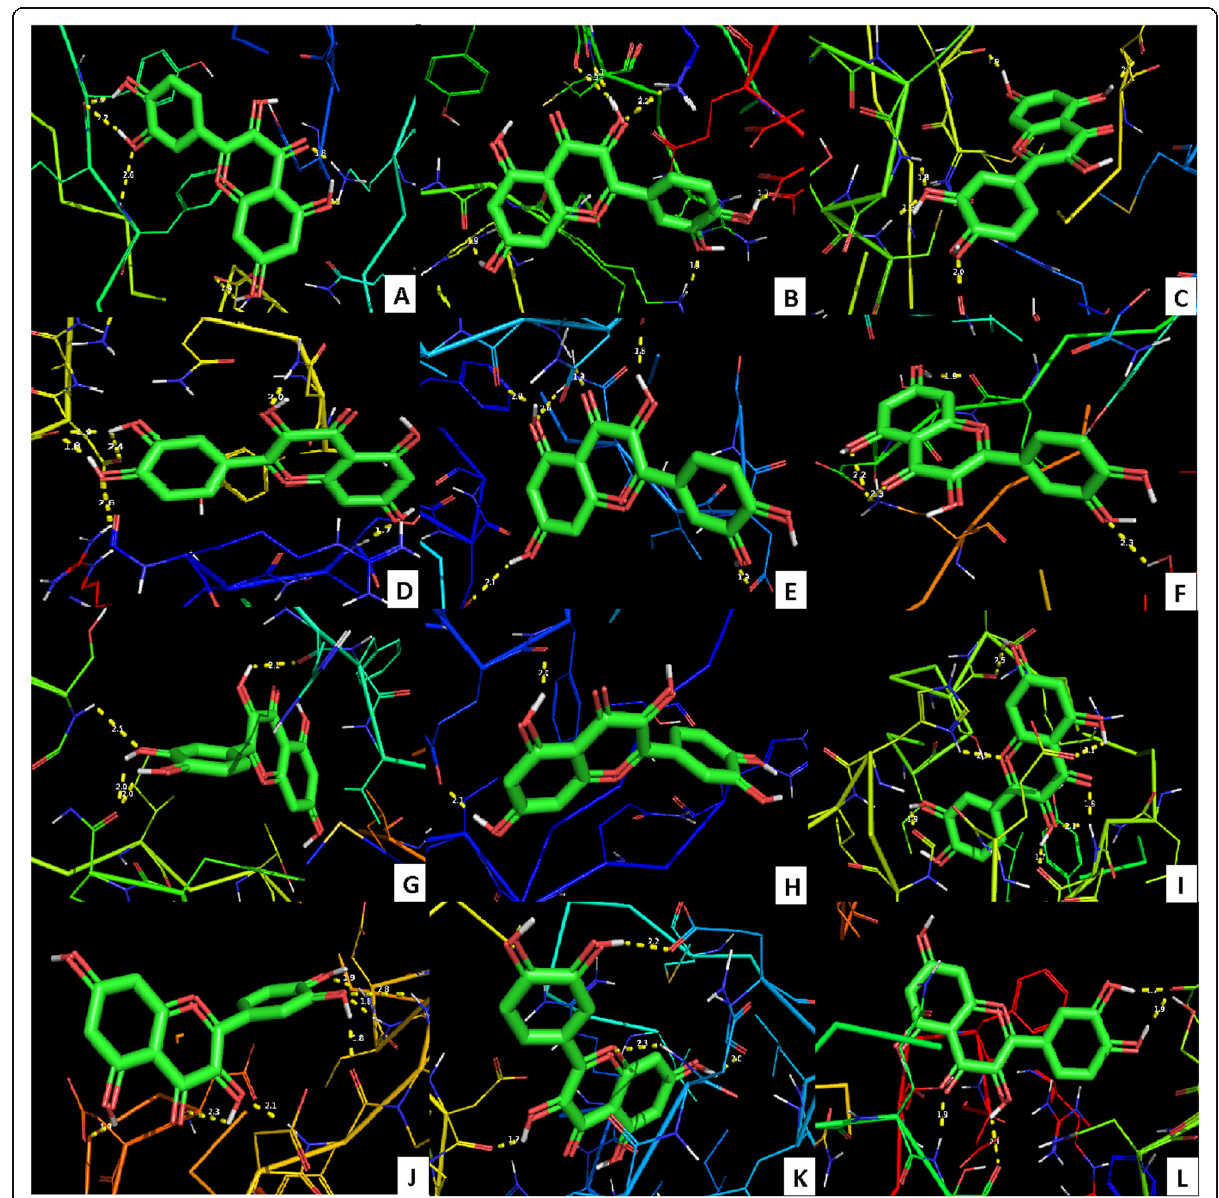
Fig. 2 Molecular docking of key proteins with quercetin. a 2019-nCoV main protease (PDB ID: 6LU7). b 2019-nCoV main protease (PDB ID: 6Y84). c 2019-nCoV main protease (PDB ID: 6YB7). d 2019-nCoV receptor-binding domain of the surface spike glycoprotein (PDB ID: 6M17). e 2019-nCoV spike glycoprotein (PDB ID: 6VXX). f 2019-nCoV RNA replicase enzyme (PDB ID: 6W9Q). g 2019-nCoV RNA-binding protein (PDB ID: 6W4B). h 2019- nCoV papain-like protease (PDB ID: 6W9C). i SARS coronavirus papain-like protease/ deubiquitinase (PDB ID: 3E9S). j 2019-nCoV